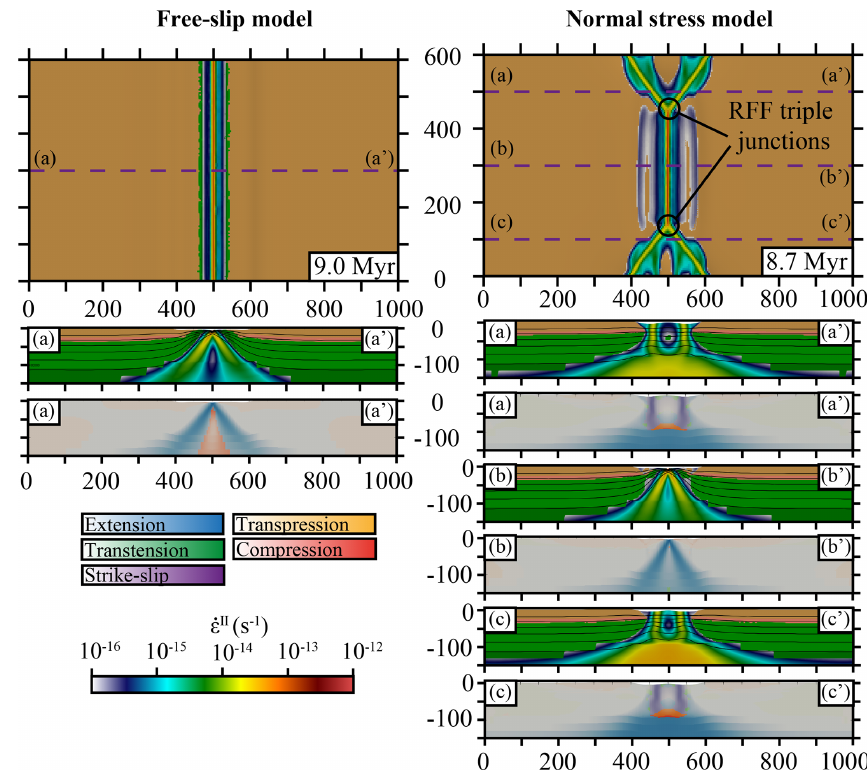
Figure 12. Map view of the models with free-slip (left) and normal stress (right) boundary conditions. The dashed lines in the upper panels indicated by (a–a (cid:48) , b–b (cid:48) , c–c (cid:48) ) correspond to the cross sections displayed in the lower panels with the same labelling. The cross sections show the numerical lithologies with the second invariant of the strain rate (Eq. 36) and the strain